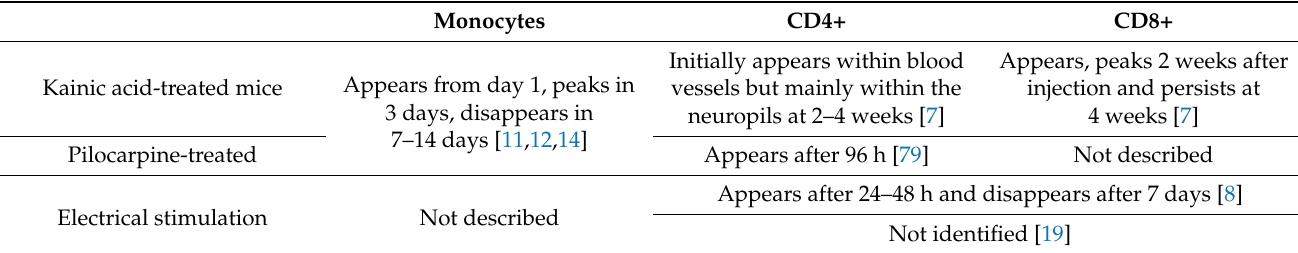
Table 3. Time course of innate and adaptive immune responses in experimental models of